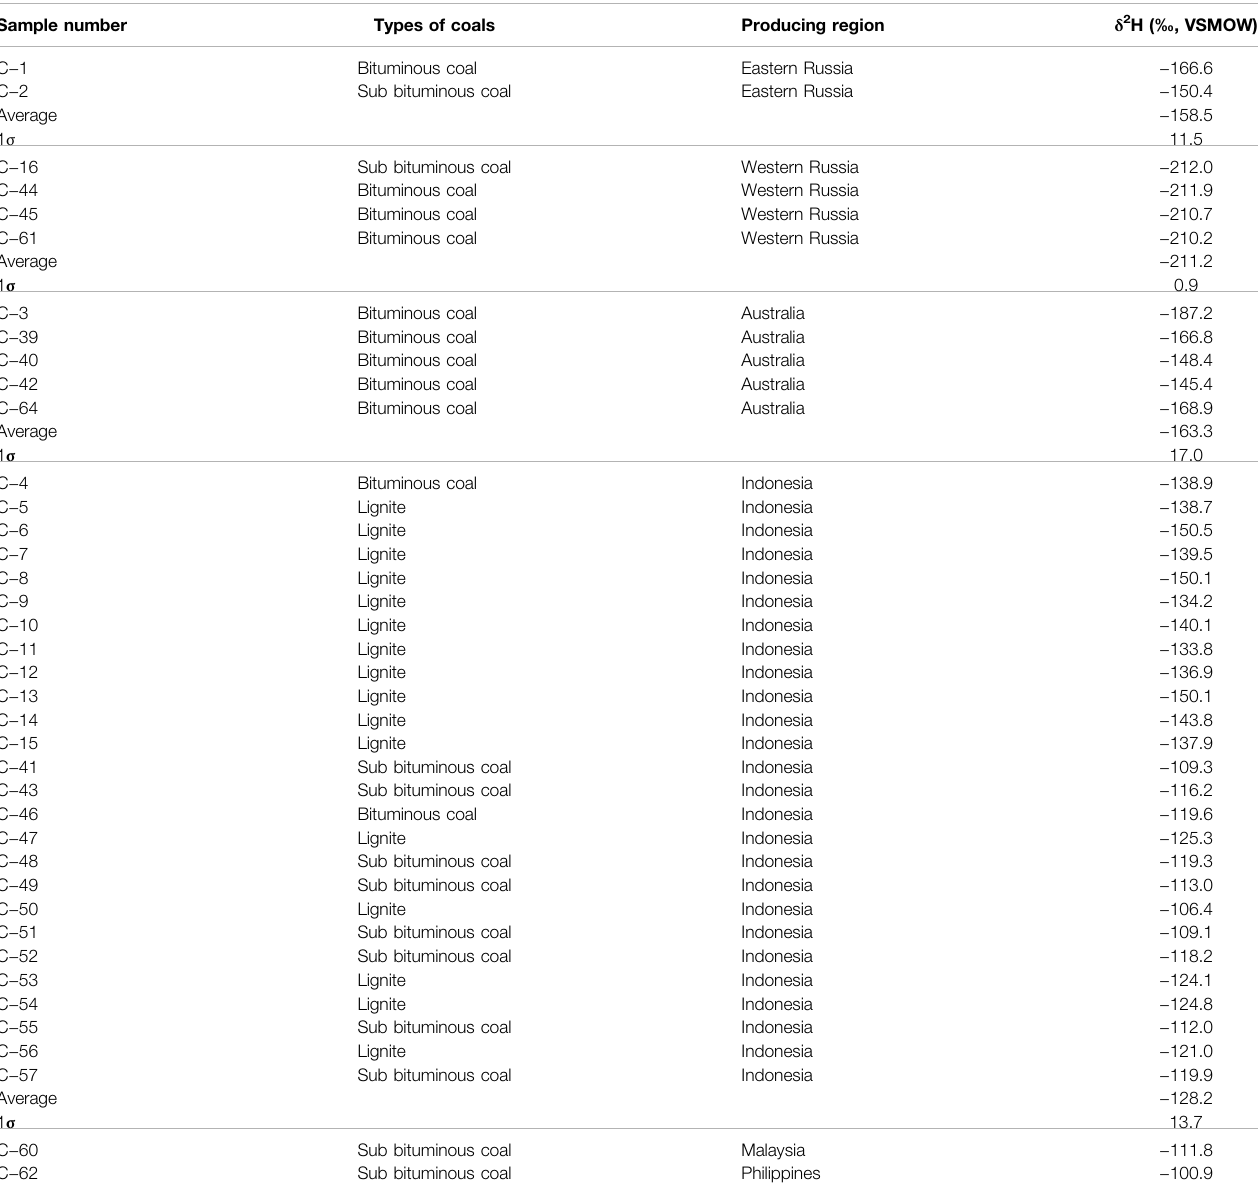
TABLE 2 | Analyses of δ 2 H of coals from different